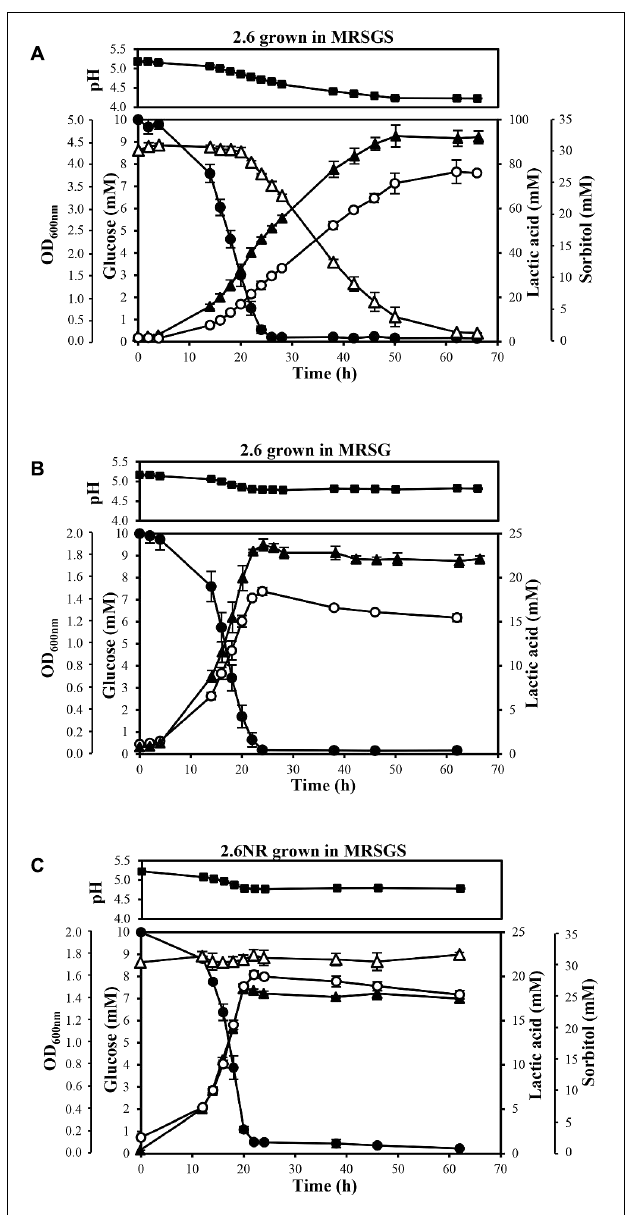
FIGURE 2 | Analysis of metabolism of P. parvulus 2.6 (A,B) and 2.6NR (C) strains. Bacteria were grown in the indicated media. Symbols: OD 600 nm ( (cid:78)